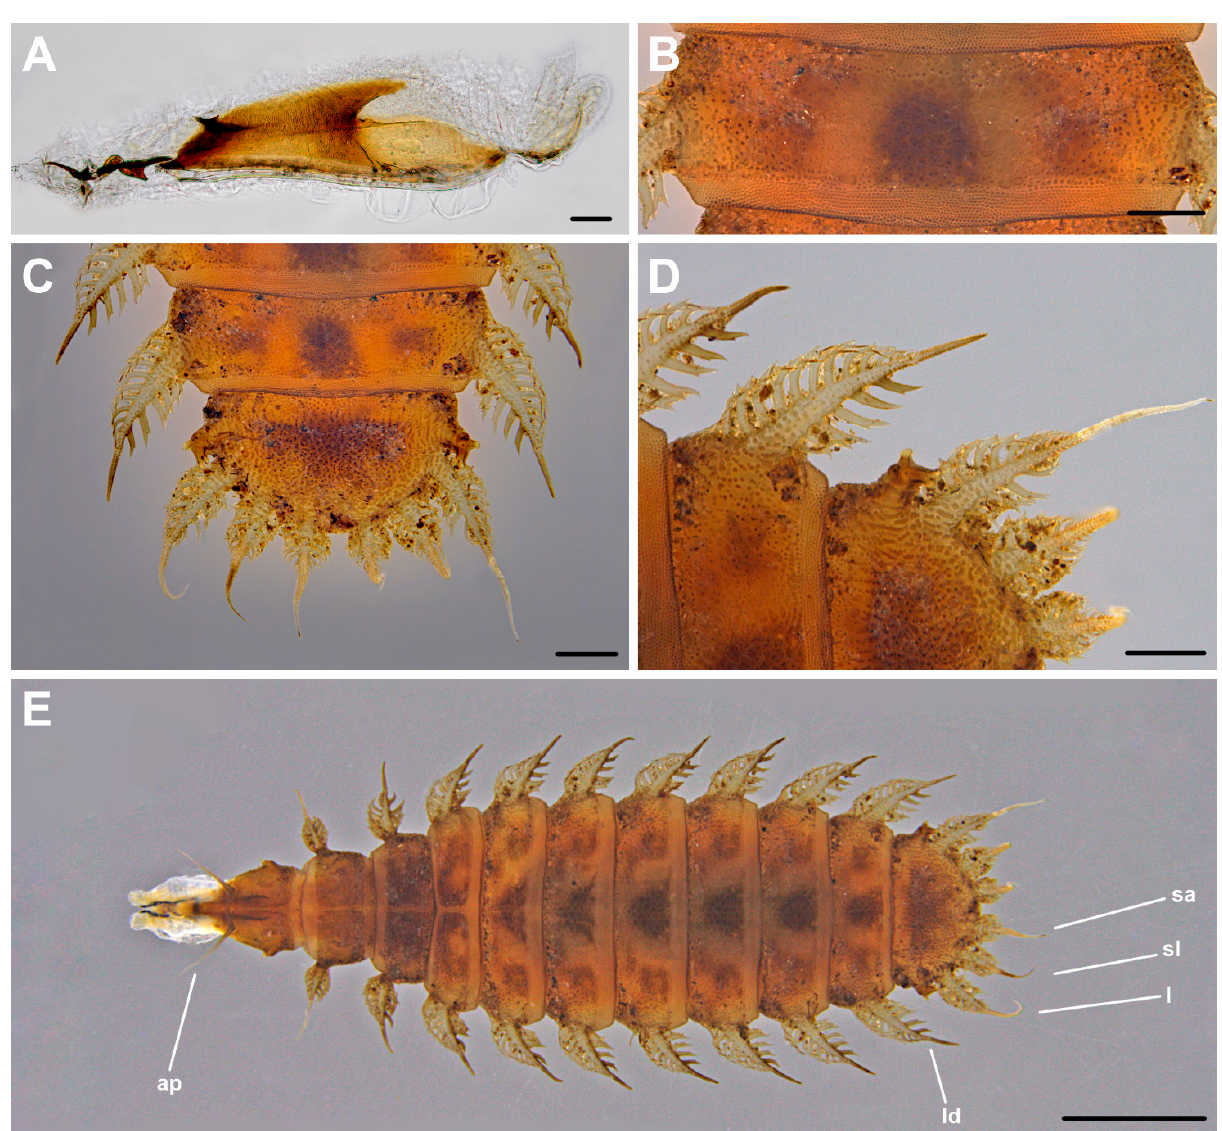
Figure 4. Third instar larva of Fannia pallitibia : ( A ) anterior body end with cephaloskeleton; ( B ) sixth abdominal segment, dorsal view; ( C ) posterior body end, dorsal view; ( D ) seventh abdominal segment and anal division, dorsal view; ( E ) larva in dorsal view. Scale bar 100 µm ( A ), 250 µm ( B – D ) and 1 mm ( E ). Abbreviations: ap, anterior process; l, lateral process; ld, laterodorsal process; sa, subapical process; sl, sublateral process.